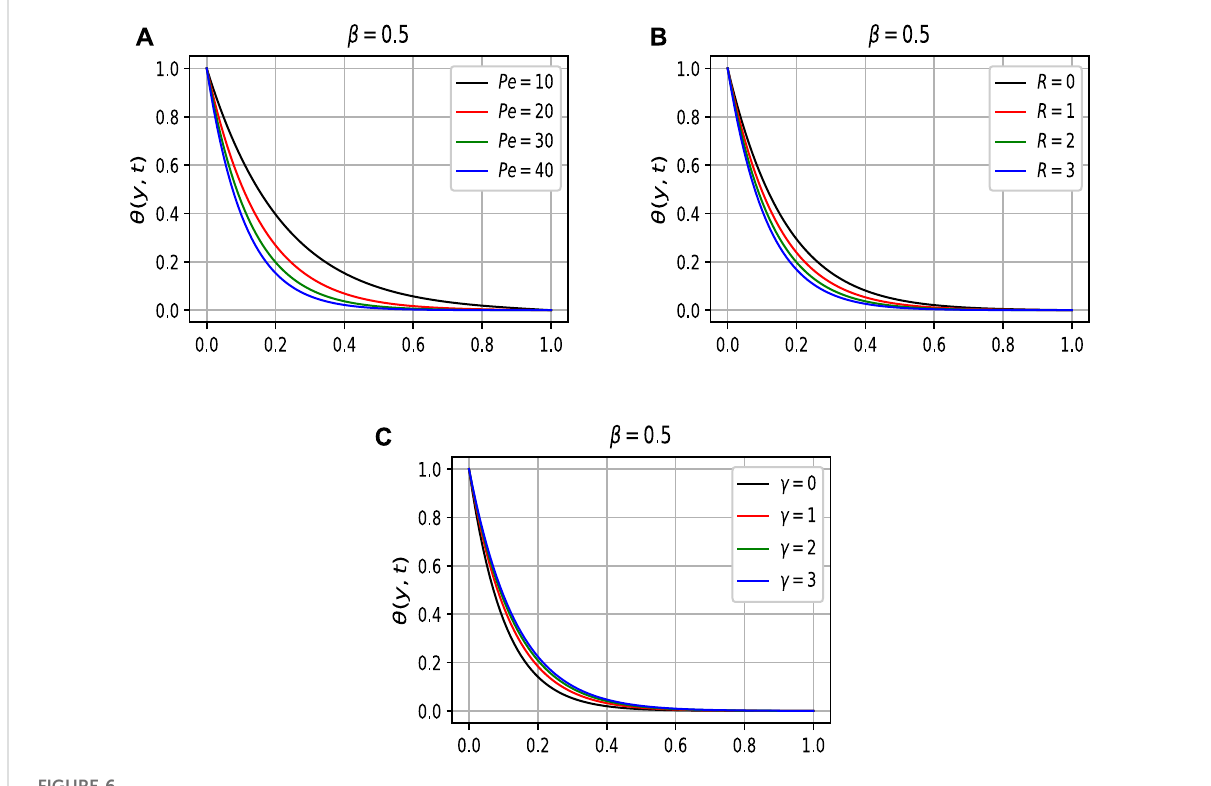
FIGURE 6 The behaviour of the boundary layer temperature as the parameters Pe , R and γ vary.